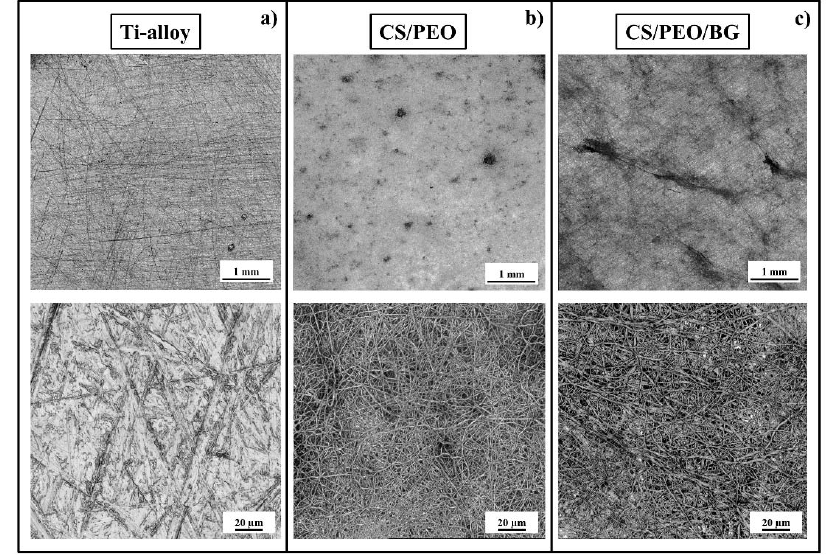
Figure 5. 3D laser micrographs of the three different substrates (Ti ‐ alloy (a), CS/PEO (b) and CS/PEO/BG (c)) obtained before bacterial and osteoblast treatments at two different magnifications (10X and 150X).